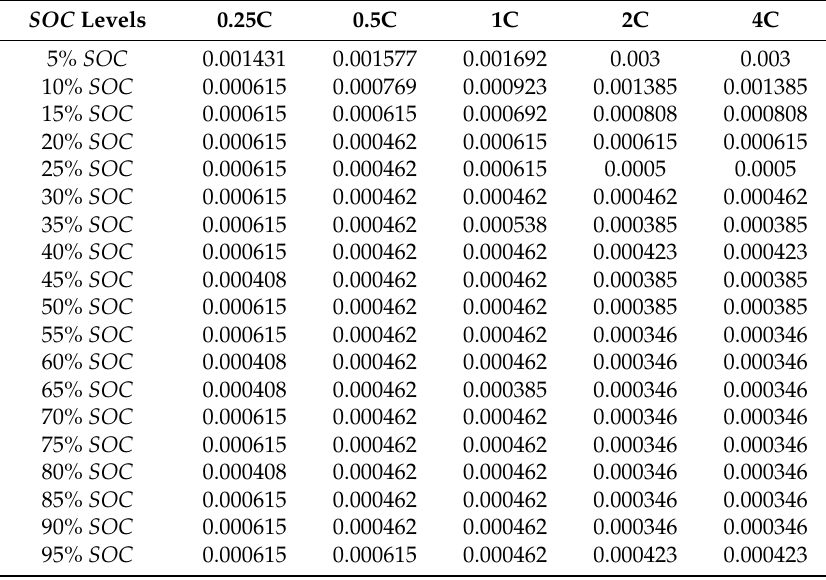
Figure 5. Voltage variations for a discharging pulse and voltage 18 s after a current pulse. Table 5. 2-D lookup table for determination of R 2 .